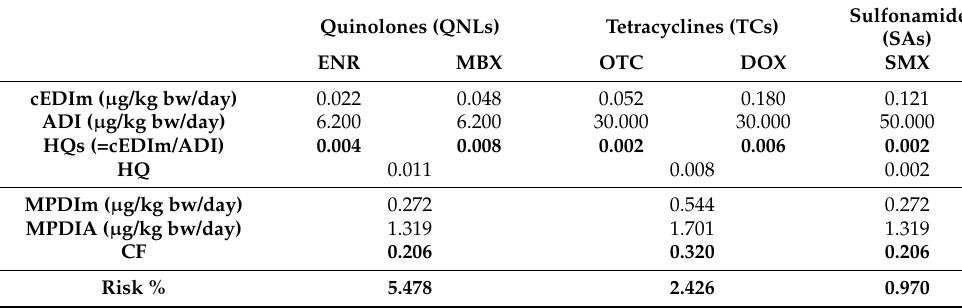
Table 8. Hazard characterization parameters (by LC–MS